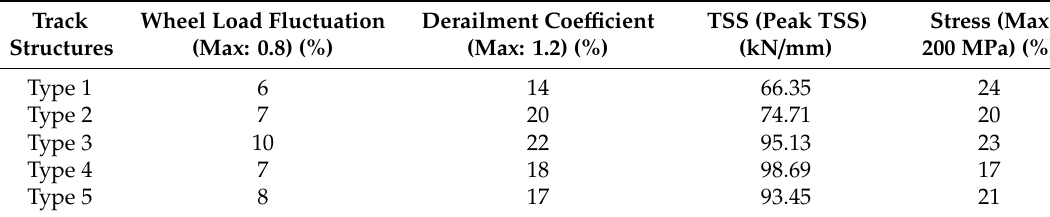
Table 12. Evaluation result of track performance (concrete track